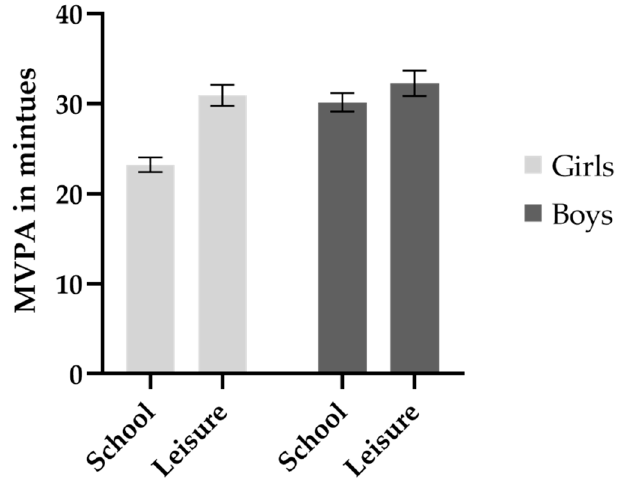
Figure 2. Minutes in moderate-to-vigorous physical activity during school time across sex, presented as means with 95% confidence intervals.